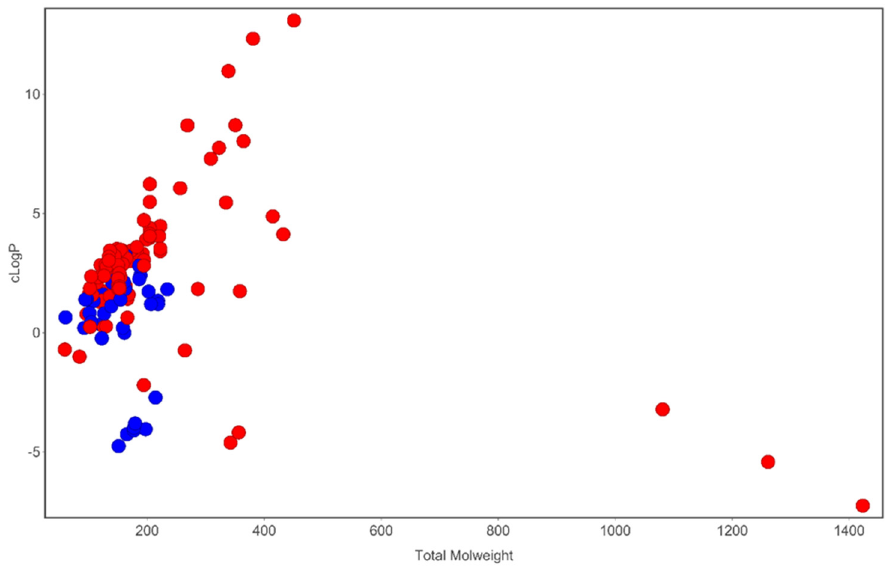
Figure 2. Analysis of cLogP and molecular weight space occupied by compounds identified in T. violacea . Blue circles are sulfur-containing compounds while red circles are compounds devoid of sulfur in their chemical structures. Plot generated using DataWarrior [54].